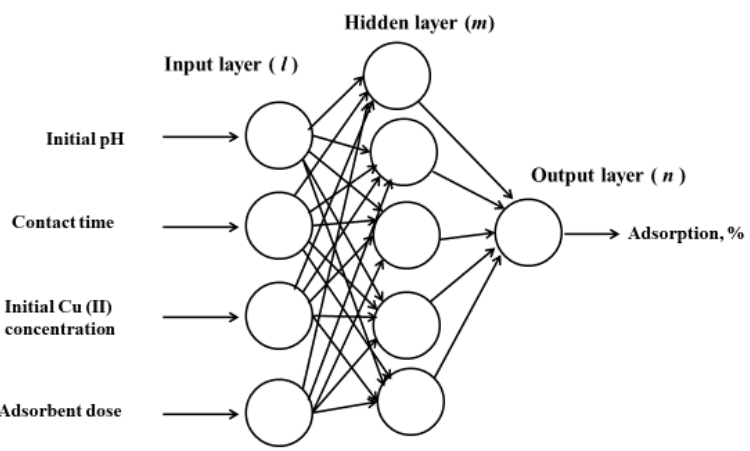
Figure 7. Artificial neural network (ANN) architecture.